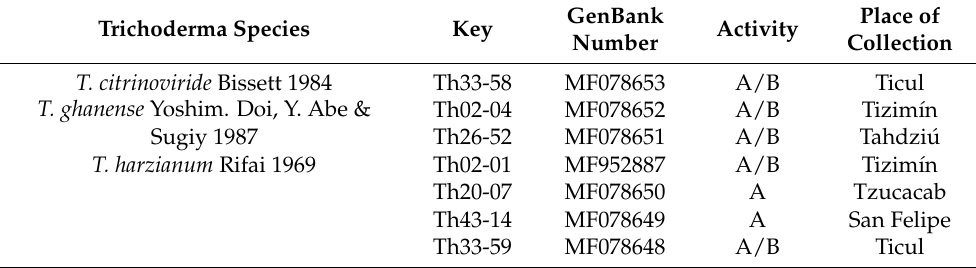
Table 1. Trichoderma strains selected and their biological